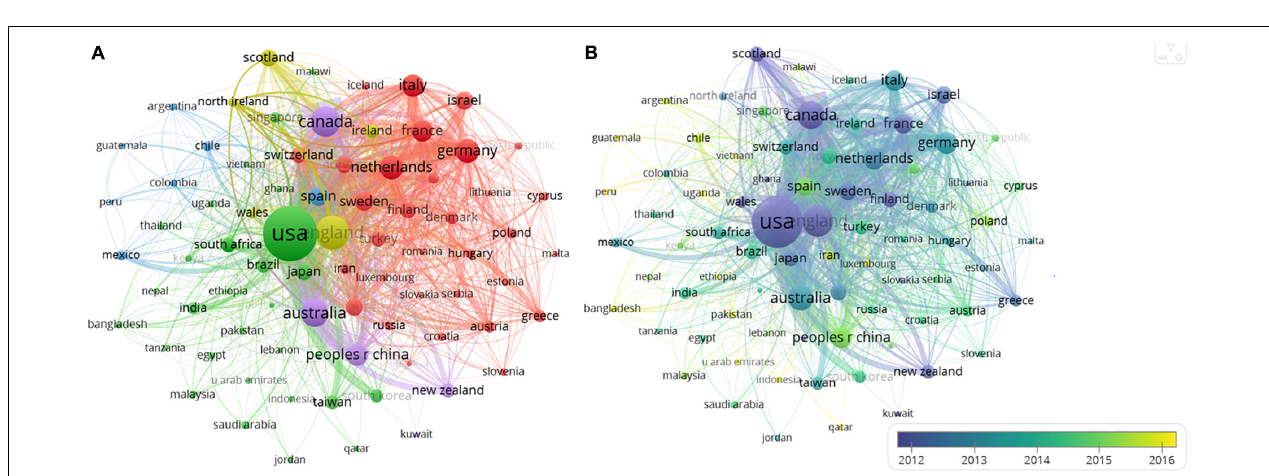
FIGURE 7 | A cooperation network visualization map of countries/regions. (A) A network visualization map; (B) a density visualization map.